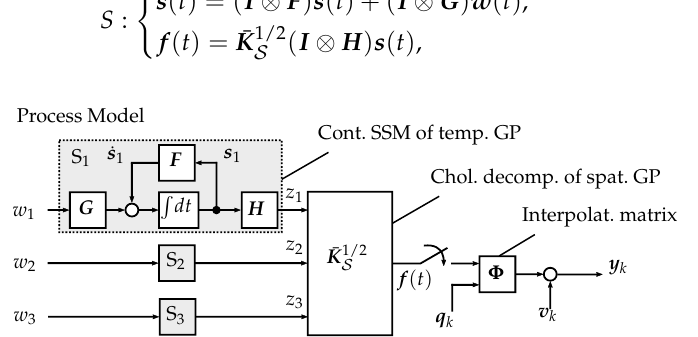
depicted Figure 7. With